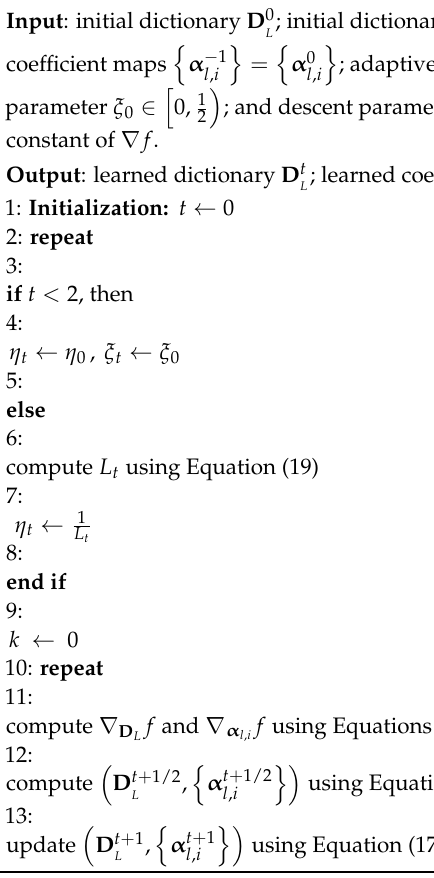
Algorithm 1 The IPGM algorithm for solving the proposed CDL problem via local